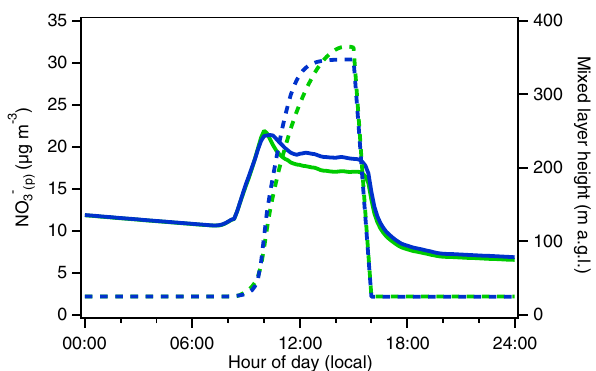
Figure B3. Average modeled surface NO − the CLASS model output (green) and a sigmoid fit to the observed ML heights (blue). The ML heights used in the model are shown in dashed